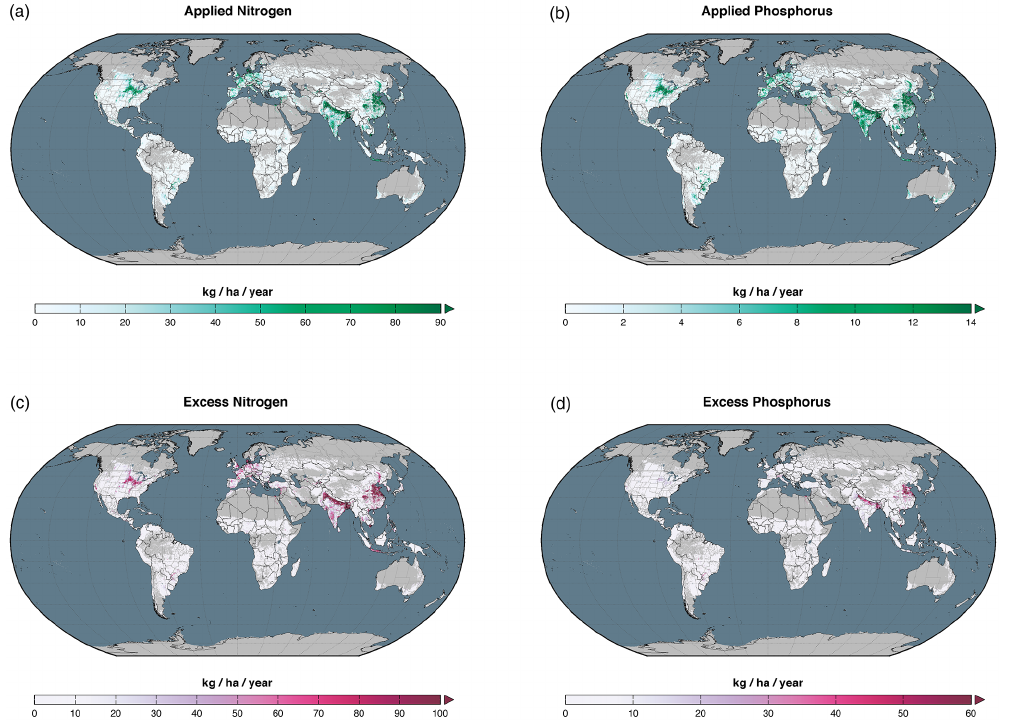
Figure 3. Applied and excess nitrogen and phosphorus in croplands. Nitrogen and phosphorus inputs and excess were calculated using a simple mass balance model (West et al., 2014), extended to include 175 crops. To account for both the rate and spatial extent of croplands, the data are presented as kilogram per hectare of the landscape. (a) Applied nitrogen, including N deposition; (b) applied phosphorus; (c) excess nitrogen; and (d) excess